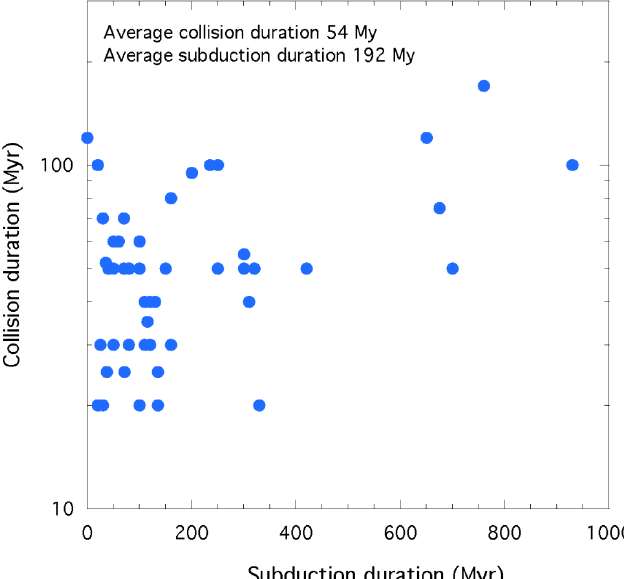
Figure 7. Graph of collision duration versus subduction duration for Proterozoic orogens (data from Appendix